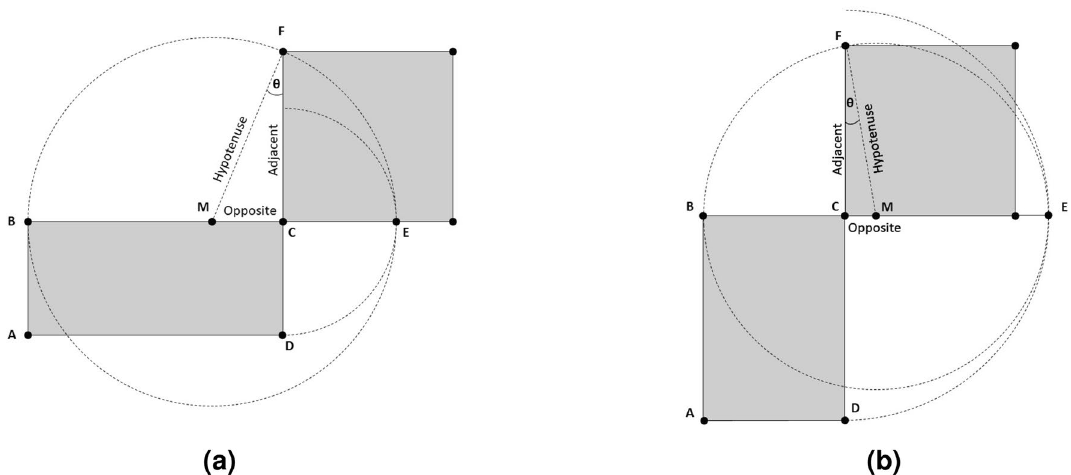
Figure 4. The quadrature of a plane rectangle: ( a ) A landscape rectangle produces positive values of θ . ( b ) A portrait rectangle produces negative values of θ